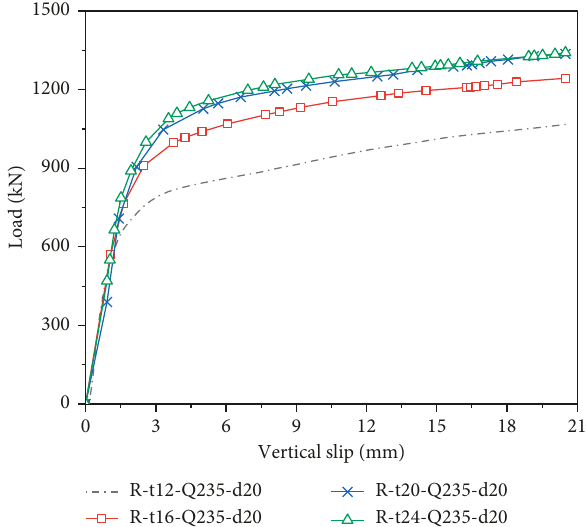
Figure 11: Load-slip curves for PBL with different plate thicknesses.